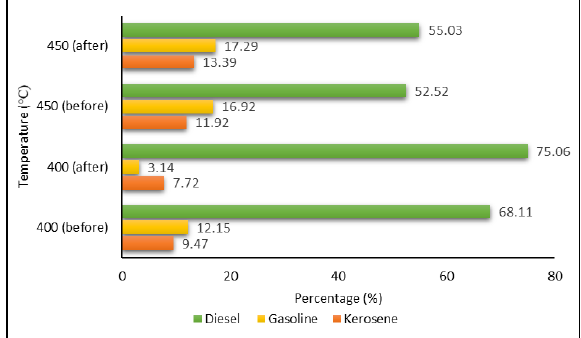
Fig. 7. Product selectivity in liquid hydrocarbon at different temperatures before and after second fractional